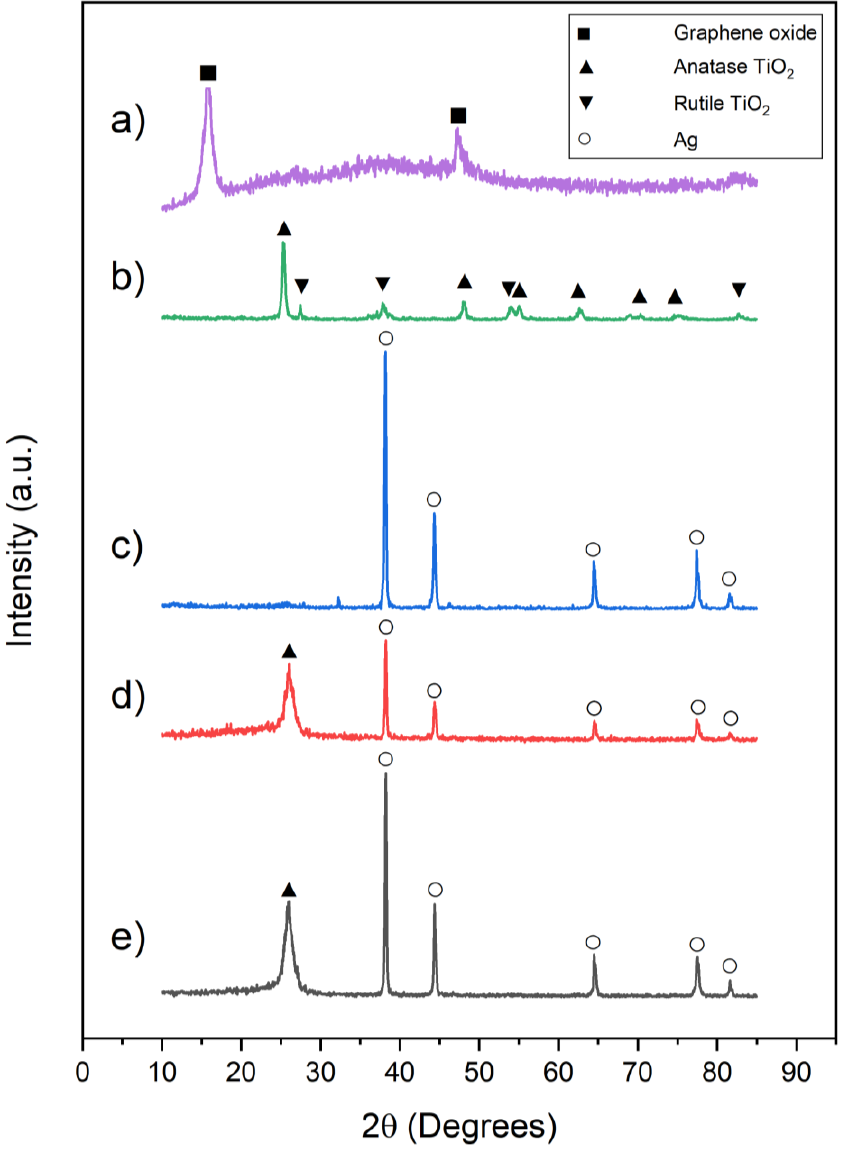
Figure 3. X-ray diffraction patterns of ( a ) GO, ( b ) P25 TiO 2 , ( c ) AgNW ( d ) AgNW/TiO 2 , and ( e ) AgNW/TiO 2 /GO samples.